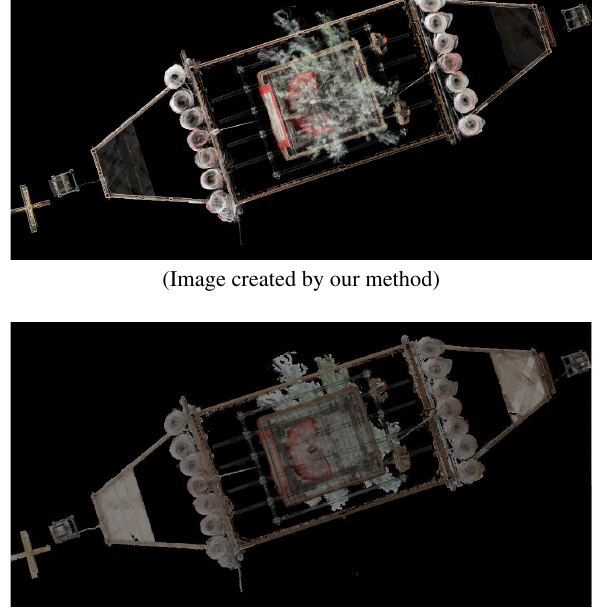
Figure 6. See-through images of the Hachiman-Yama float look- ing down from above. The top image was created by our method, and the bottom image was obtained by the commonly used quick transparent point-based rendering method, in which the colors of the projected 3D points are simply averaged at each pixel.